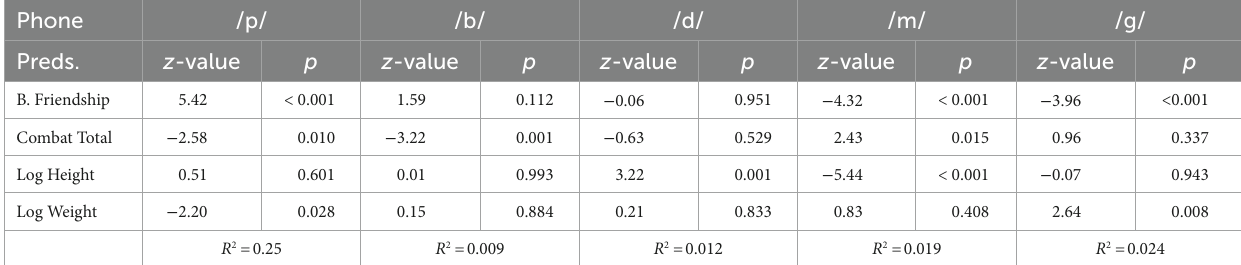
TABLE 8 Results of a series of multivariate Poisson regression analyses examining base friendship, size, and combat variables and the frequency of each phoneme in all languages. Phone /p/ /b/ /d/ /m/ /g/